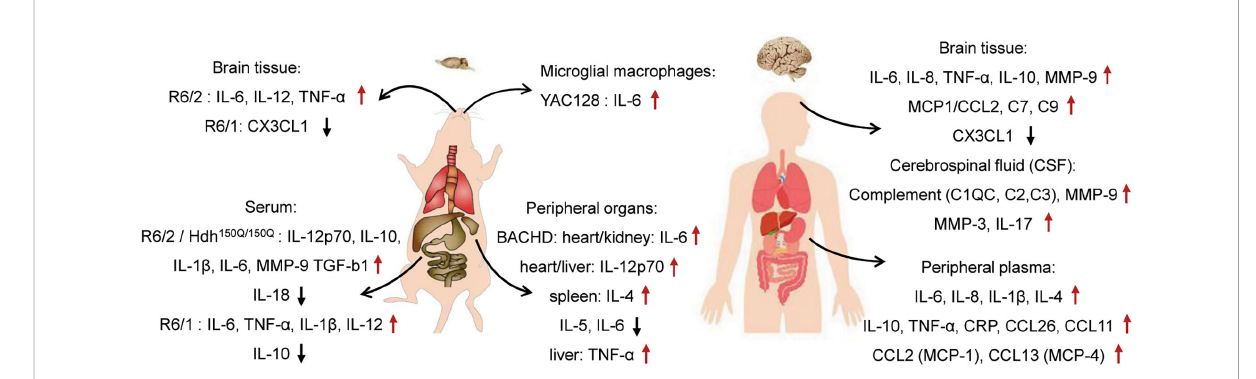
FIGURE 2 Schematic summary of brain and peripheral in fl ammatory changes in HD mice and